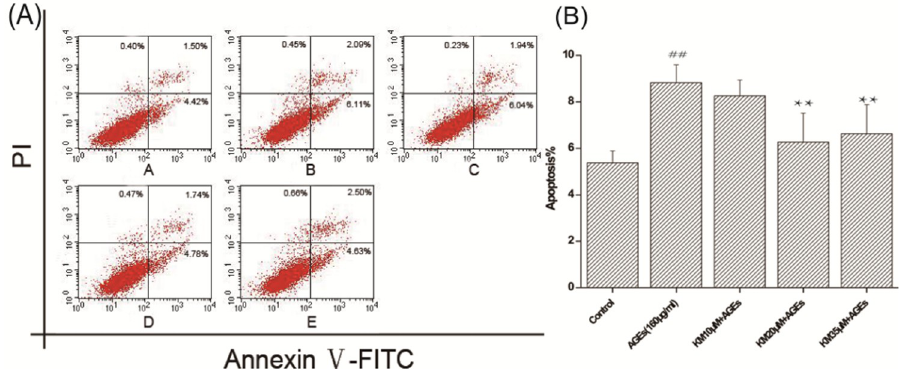
Figure 6. KM treatment reduces the rate of apoptosis in AGE-treated GMCs. Detection of apoptosis rate with annexin V and PI. Cells were stained with annexin V and PI after being treated with AGEs (160 μg/mL) and KM (10, 20, and 35 μM). ( A ) Percentages of apoptotic cells were determined by flow cytometry. FITC, Fluorescein Isothiocyanate. ( B ) The results were presented as mean ± SEM. ** p < 0.01, vs. AGEs group; ## p < 0.01, vs. control group.